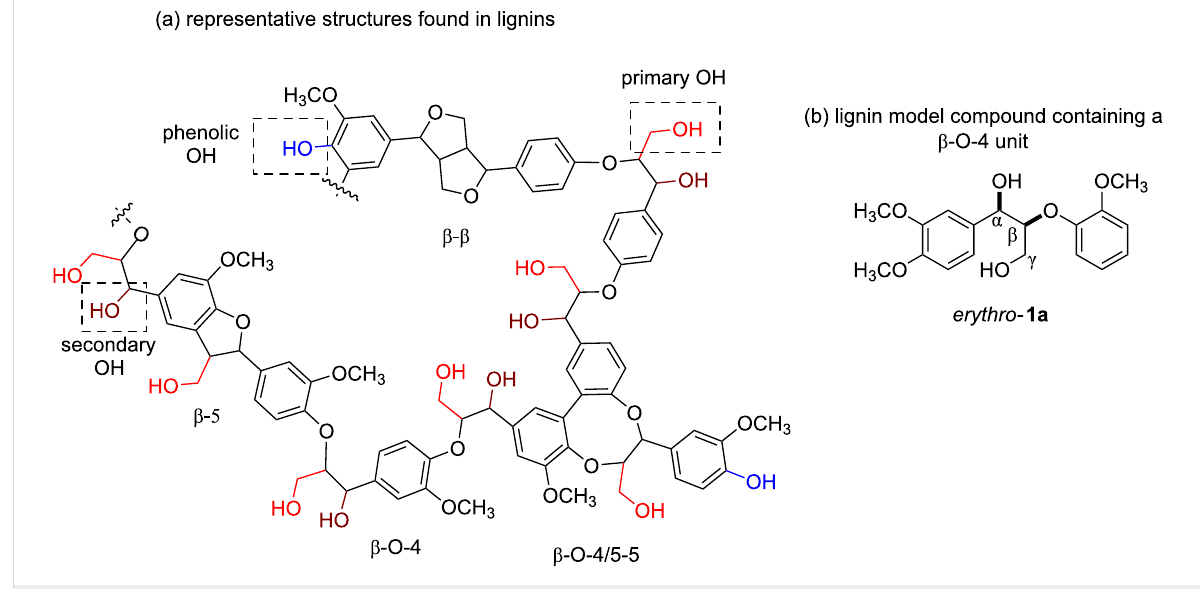
Figure 1: (a) Molecular representation of lignin. (b) Lignin model compound erythro- 1a .